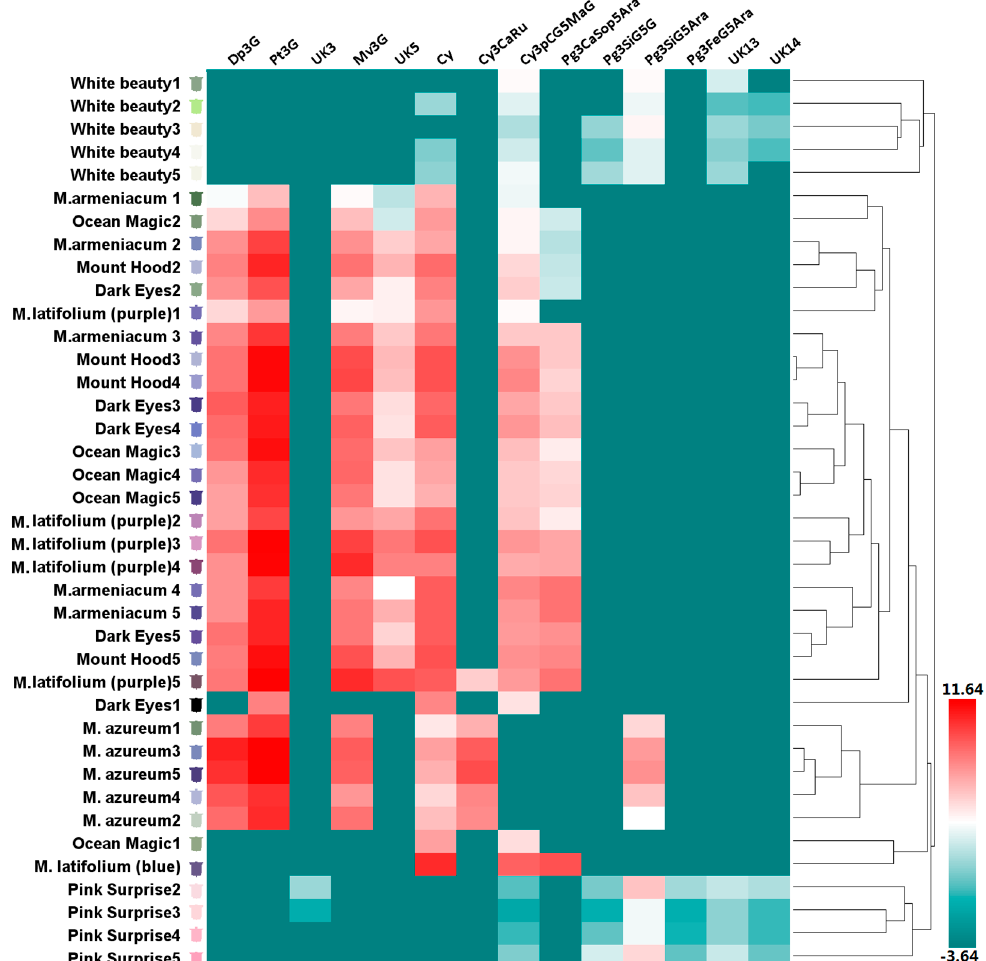
Figure 3. Anthocyanin profiles in tepals of eight grape hyacinth cultivars. The Y -axis represents tepals at stages 1–5 from different grape hyacinth cultivars. The X-axis represents the relative content of individual anthocyanins in different tepals. The average anthocyanin content of three independent replicates was shown on grids with different color scale levels representing the relative log2 at different samples, respectively. Flower color was recorded as three-dimensional CIEL*a*b* values and reproduced by photoshop using L, a*, b* values at all development stages investigated in this study. Cy—